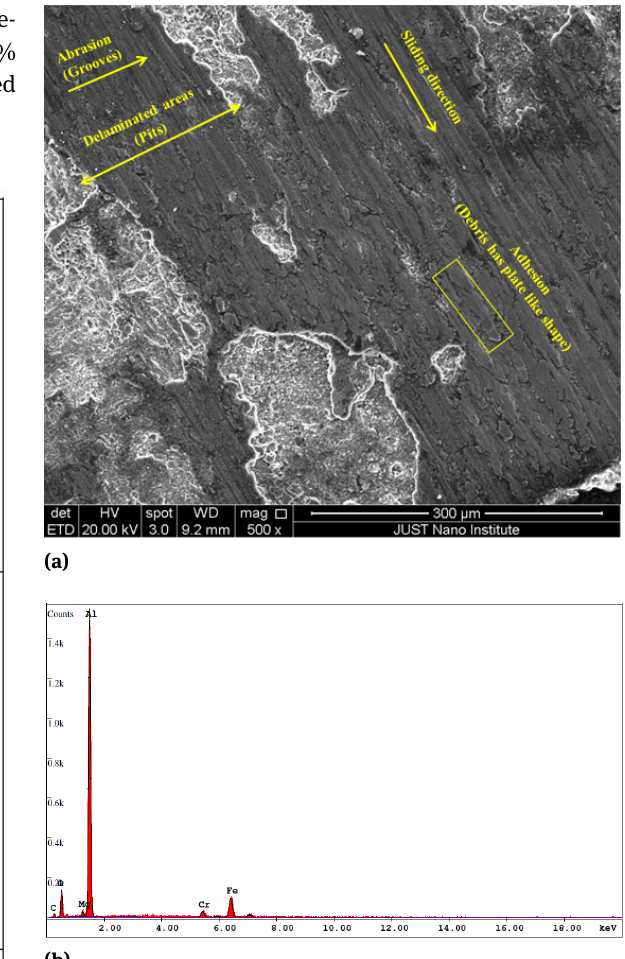
Figure 11: (a) SEM micrograph of worn out surfaces of Al-1.5Mg- 1.5Sn composite showing three types of wear; abrasion, adhe- sion, and delamination wear, (b) EDX analysis of worn surface of Al-1.5Mg-1.5Sn